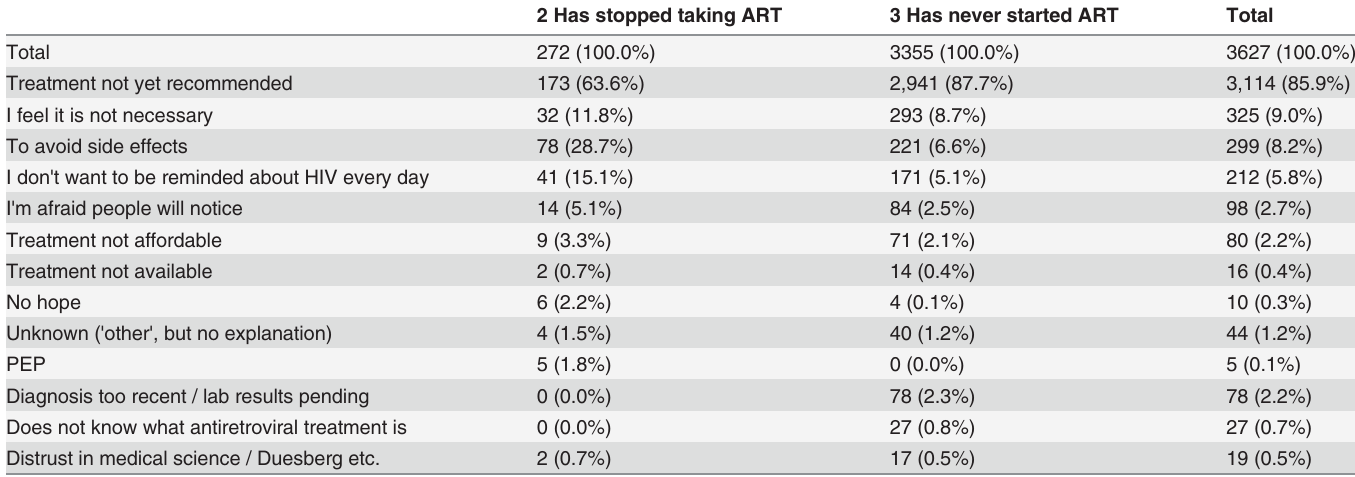
Table 2. ART treatment status and reasons for not taking ART among MSM living in Europe with diagnosed